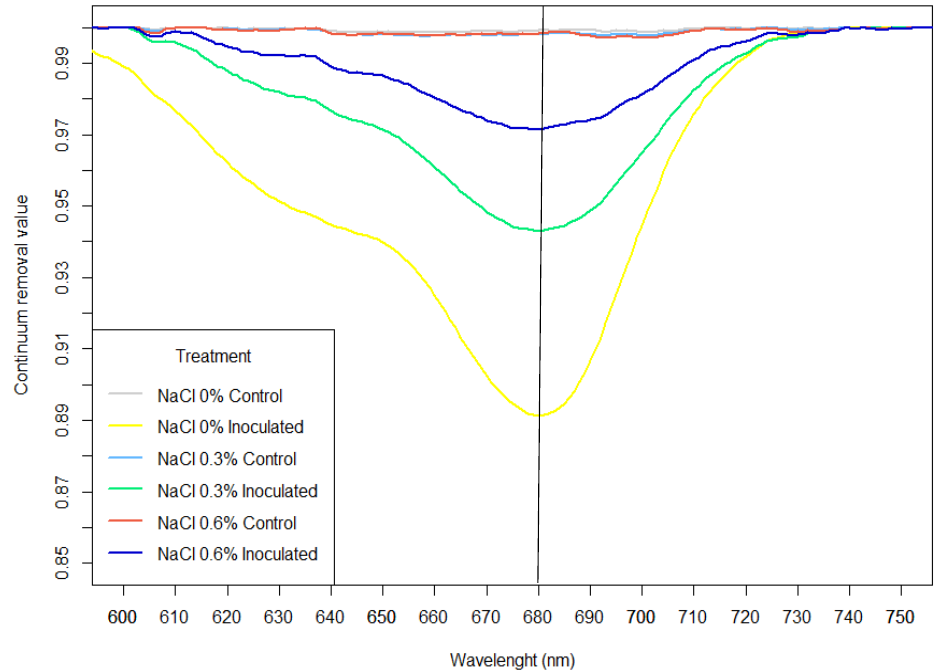
Figure 8. Continuum removal curves between 600 and 750 nm obtained for the control and inoculated samples three months after the application of the different NaCl concentrations tested in the experiment.